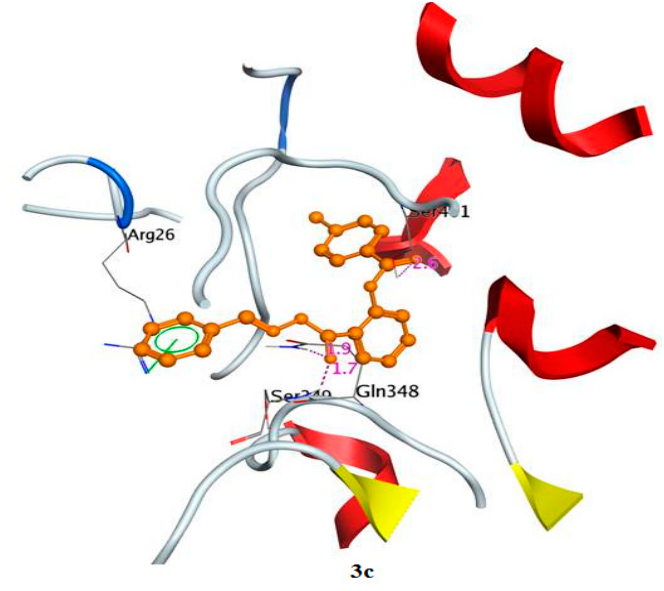
Figure 5. Docking pose for compound 6a , as a representative, in the active site of glucosamine- 6-phosphate (GlcN6P) synthase. phosphate (GlcN6P)